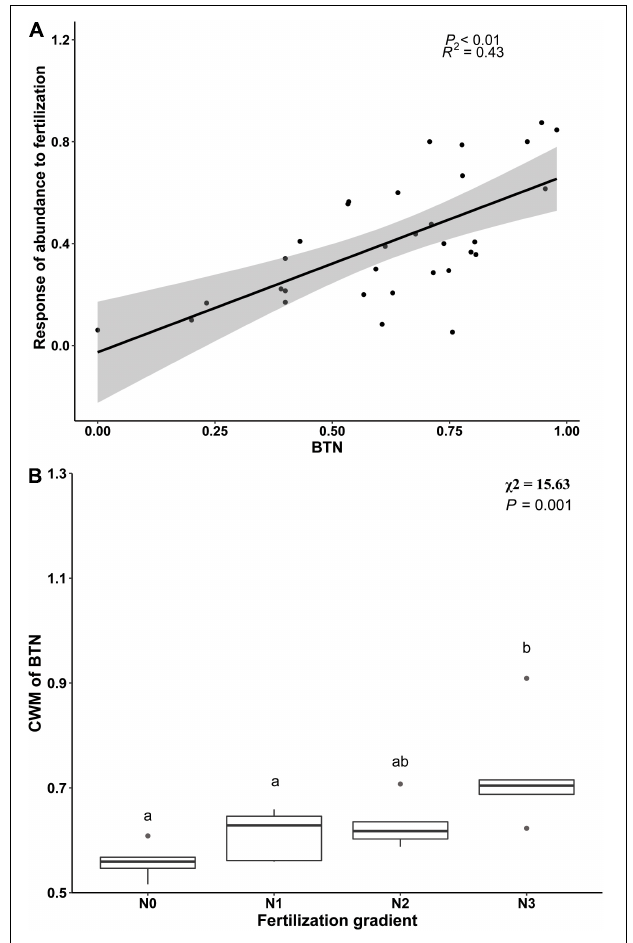
FIGURE 3 | The relationship between response of species abundance to fertilization (R f ) and breadth of temperature niche for germination (BTN) at species level (A) and the effect of nitrogen addition (N0, 0 g N m − 2 year − 1 ; N1, 5 g N m − 2 year − 1 ; N2, 10g N m − 2 year − 1 ; N3, 20g N m − 2 year − 1 ) on CWM (community weighted mean) of BTN (B) . Ends of a box represent first and third quartiles; thick line in box, the median; ends of vertical line (whiskers), maximum and minimum; and dots,